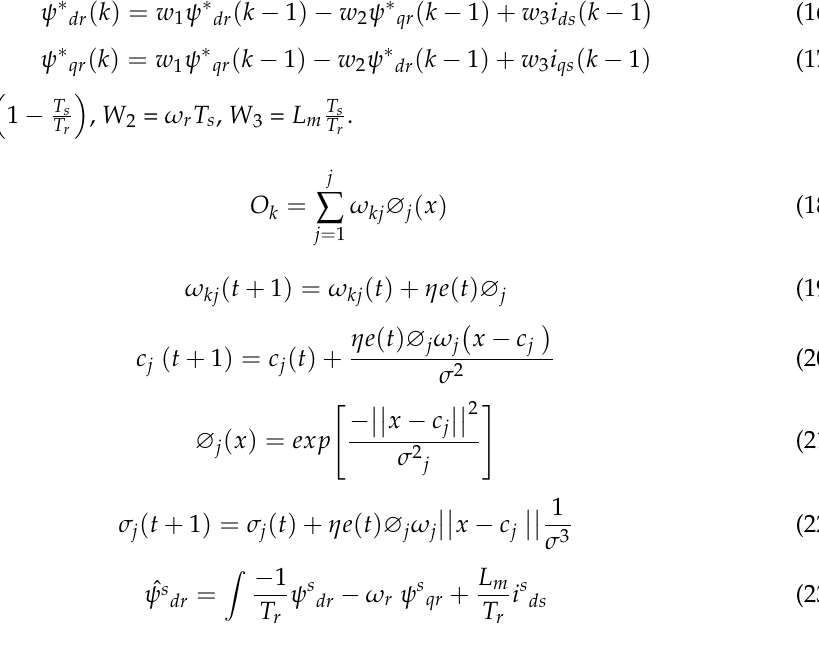
Figure 5. Neural network ‐ based adaptive model.